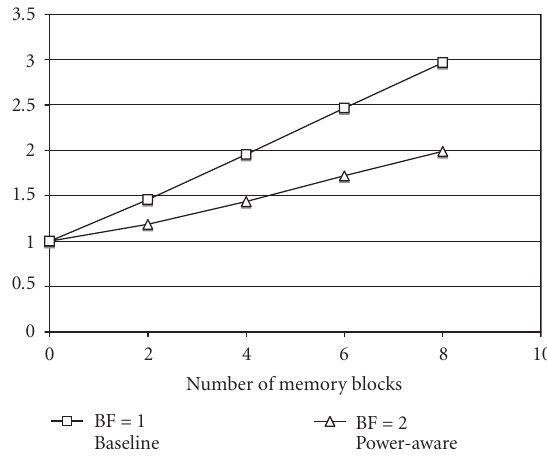
Figure 18: Impact on energy when increasing the number of 4096- bit